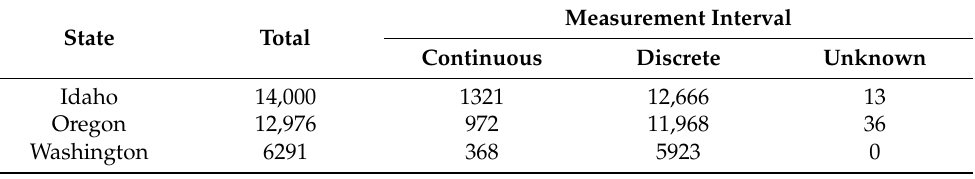
Figure 3. Number of streamflow monitoring locations with continuous, discrete, or unknown measurement intervals in each state. Note, unknown intervals are small percentages but account for 13 locations in Idaho and 36 locations in Oregon. Table 1. Number of streamflow monitoring locations and interval of measurements in each state.